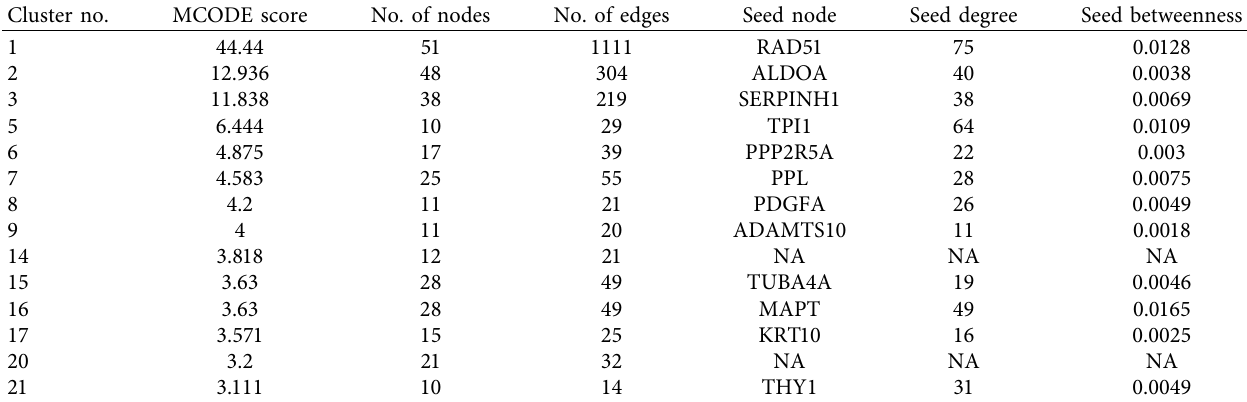
Table 1: A total of 14 clusters were detected in the PPI network associated with the primary ameloblastoma. Cluster